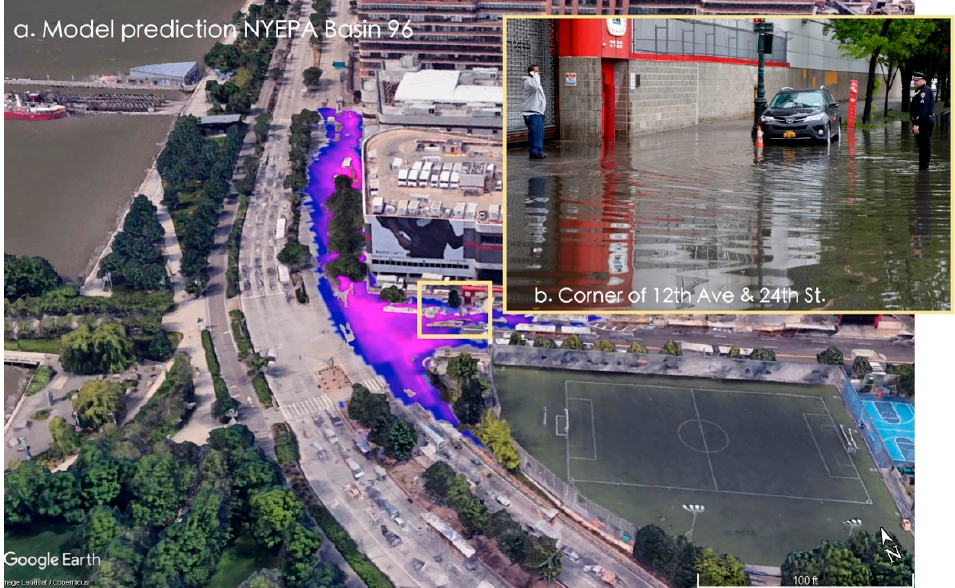
Figure 8. ( a ) Model Prediction for May 5, 2017 in NYEPA Basin 96—Extreme flooding event for 12th Avenue between 24th and 25th streets ( b ) Flooding image taken on May 5, 2017 at the corner of 12th Avenue and 24rd street (Carlo Allegri, Reuters).